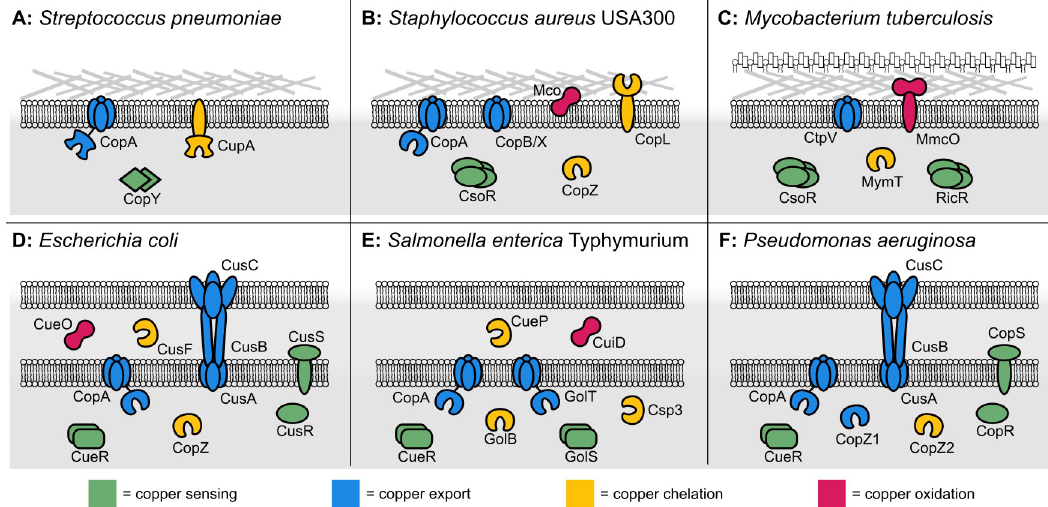
Fig 4. Copper resistance in human pathogens. Despite individual variations, most human pathogens share a common pattern of copper resistance proteins, involving four key functions: copper sensing (green), export (blue), chelation (ochre), and oxidation (magenta). The first three functions (sensing, export, and chelation) are common to the majority of pathogens, and many also include the fourth function (oxidation). In some cases, the copper-homeostasis suite can also vary across different strains or serotypes (most notably in S . aureus and S . enterica ). Copper oxidation only occurs outside of the cytosol, and it may contribute to slowing down copper entry into the cytosol. All P-type ATPases belong to a single family (CopA) which is conserved across the tree of life (including eukaryotes). Different subfamilies of the ATPase may feature different terminal metal-binding domains, and these are homologous to that organism’s cytosolic chaperone. (A) Streptococcus pneumoniae contains a minimal set of copper-homeostasis proteins, including the CopY sensor, the CopA exporter, and the CupA chaperone. (B) The common USA300 strain of Staphylococcus aureus contains two copper-efflux pumps (CopA and CopB/X) as well as a cell-surface associated chelator (CopL) and multicopper oxidase (Mco). (C) Mycobacterium tuberculosis has a minimum copper-homeostasis system with the CtpV efflux pump, the MymT metallothionein, and the MmcO oxidase; however, this system is controlled by two separate (but homologous) regulators: CsoR for CtpV, and RicR for MymT and MmcO. (D) As a gram-negative organism, Escherichia coli features a rich suite of periplasmic copper-homeostasis proteins, including the CusSR two-component sensory system, the CusCBA efflux pump, the CusF chaperone, and the CueO oxidase. Copper homeostasis in the E . coli cytoplasm is minimal, with only the CueR regulator, the CopA pump, and the CopZ chaperone dealing with copper homeostasis in this compartment. (E) Although related to E . coli , Salmonella enterica sv. Typhimurium lacks systems for periplasmic copper sensing or efflux; conversely, it carries a duplication of the cytoplasmic copper-homeostasis system (the Gol proteins) and an additional copper-storage protein (Csp3). (F) Pseudomonas aeruginosa features copper sensing and efflux both in the cytosol and the periplasm, but no periplasmic copper chelator or oxidase have been identified to date.